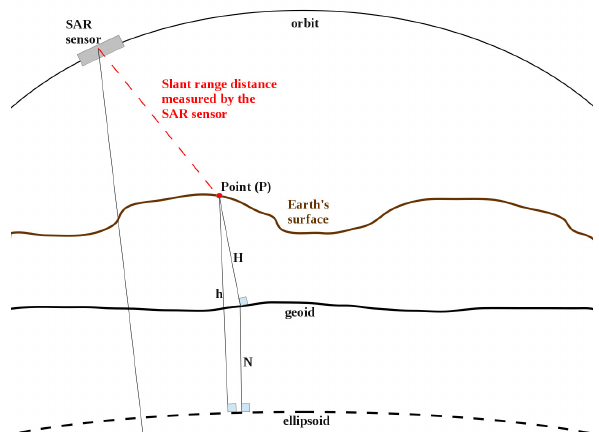
Figure 1: The geoid undulation.